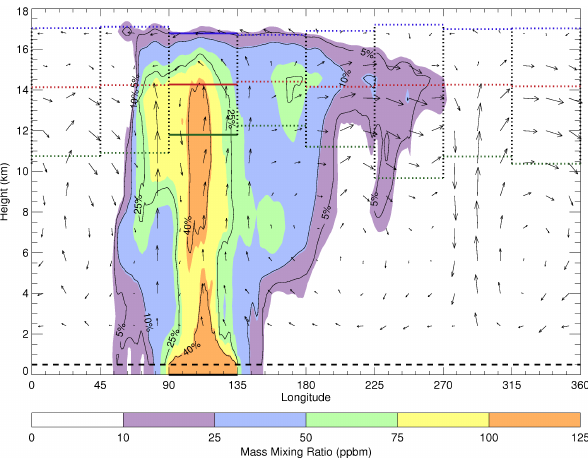
Fig. 2. Longitude-height distribution of a surface emitted tracer with an infinite lifetime from the Maritime Continent domain (MC). The tracer distribution is averaged between latitudes 20 ◦ N–20 ◦ S over the last 10 days in the November integration. (1) mass mixing ra- tios (shading) and (2) percentages (black contours) relative to the mean mass mixing ratio of all 8 tracers over all 8 regions at 0.5km (long-dashed black line). TTL surfaces are here defined by the LRM (green lines), Q clear =0 level (red lines) and CPT (blue lines). The TTL surfaces represented by the solid lines highlight the receptor regions which correspond to vertical transport for this tracer. Wind vectors are arbitrarily scaled for the best visual representation of flow.